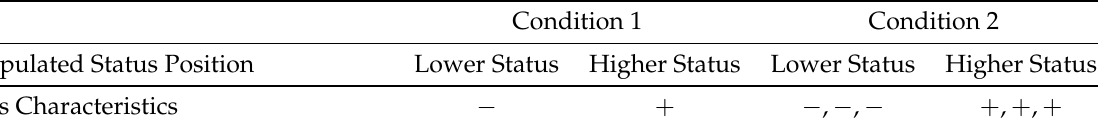
Table 1: Dyadic status structures by